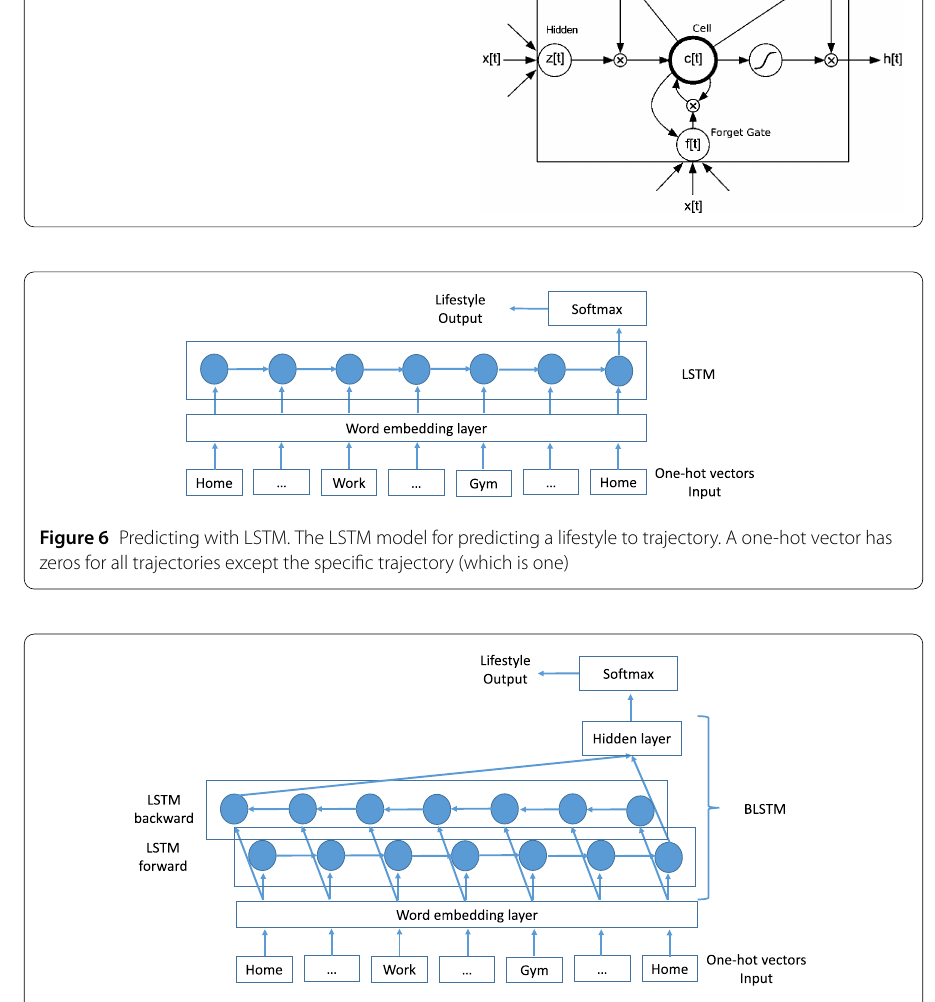
Figure 7 Predicting with BLSTM. The BLSTM model for predicting a lifestyle to trajectory. A one-hot vector has zeros for all trajectories except the specific trajectory (which is